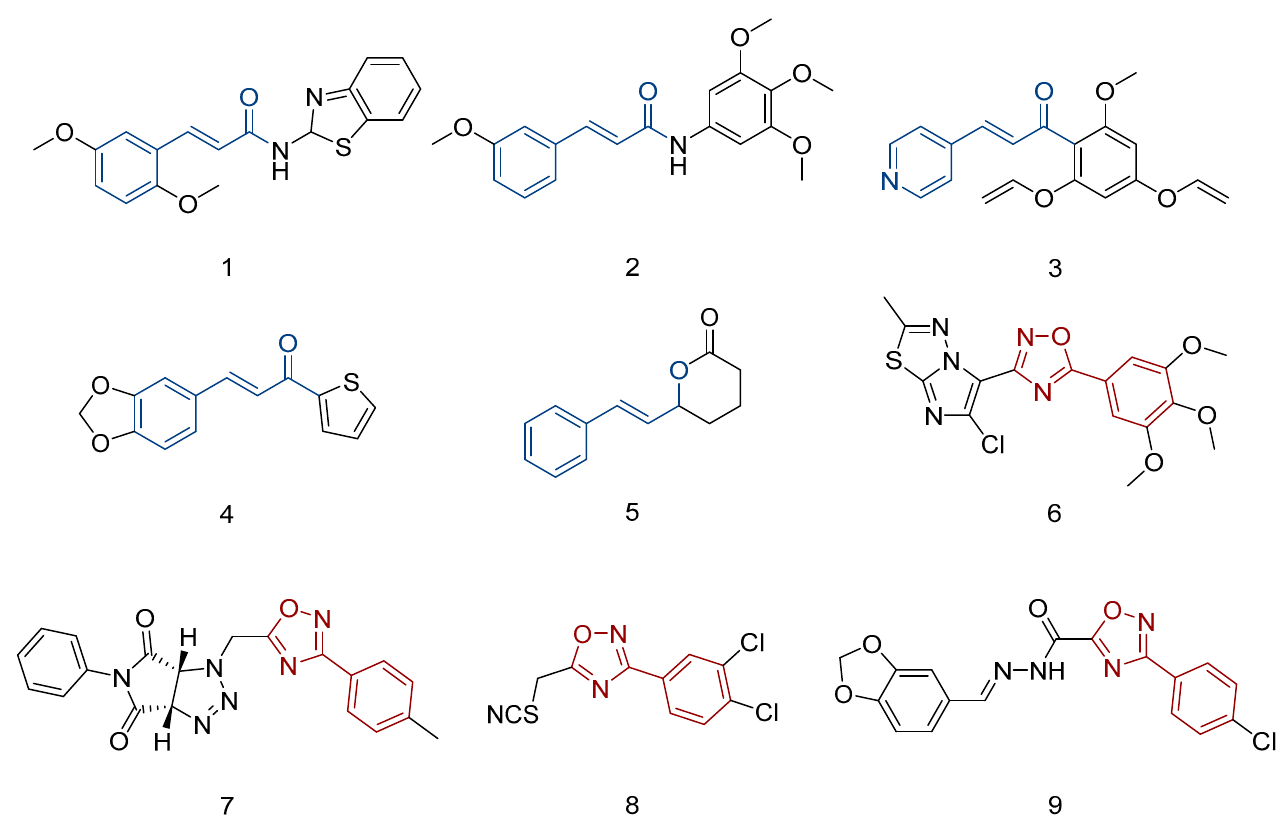
Figure 1. Chemical structures of compounds with described antitrypanosomal and antimitotic activity bearing the ( E )-2-aryl-vinyl (in blue) or the 3-aryl-1,2,4-oxadiazole (in red) moieties. Based on the reported activity panel, our research group proposed a series of 3-aryl-5-(2-aryl-( E )-vinyl)-1,2,4-oxadiazoles ( 9 – 25 , Figure 2) with potential antiproliferative ac-